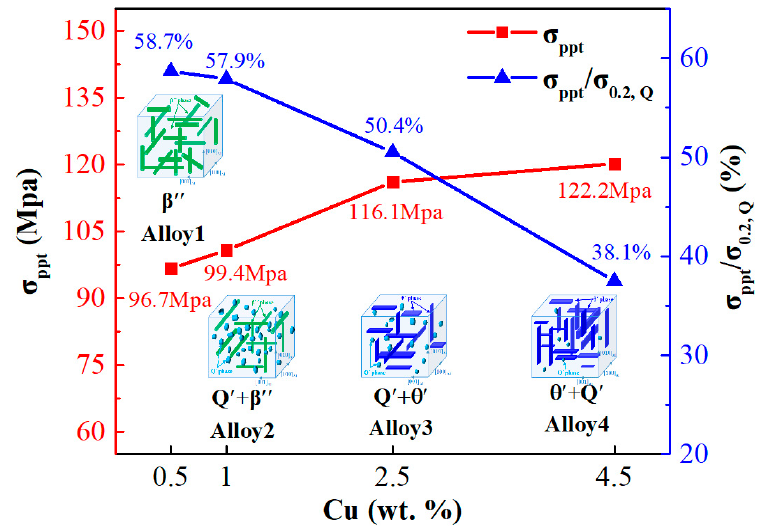
Figure 22. Influence of precipitation on the strength of the alloy.